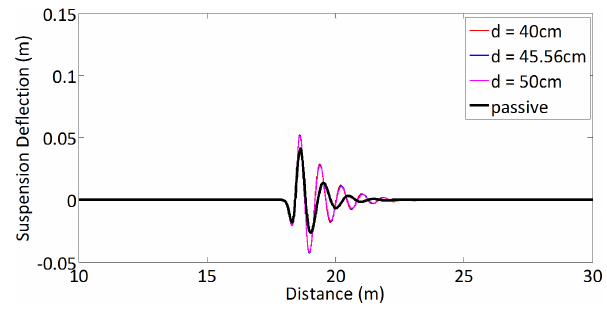
Figure 11. Time Domain Simulation: Suspension Deflection.